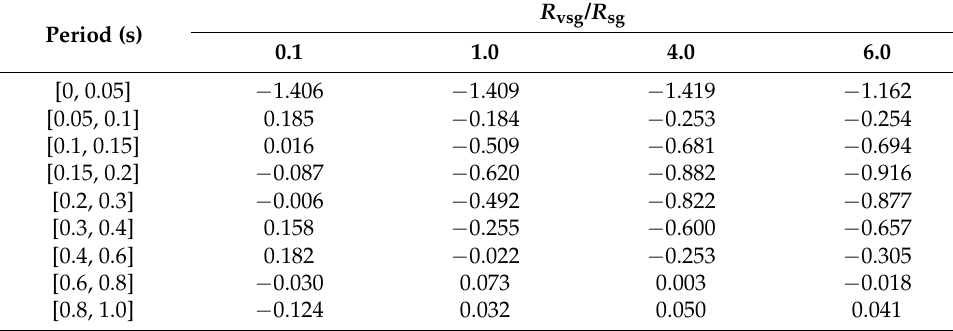
Table A7. RoCoF (Hz/s) ( R vsg was